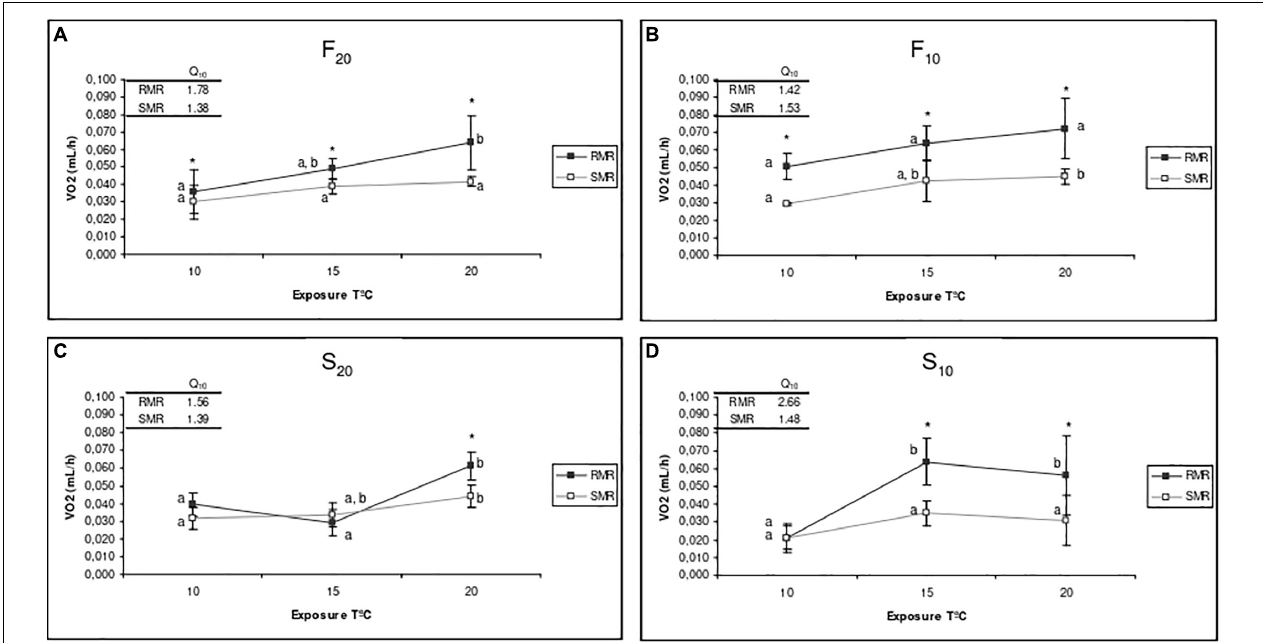
FIGURE 4 | Routine metabolic rate (RMR) and standard metabolic rate (SMR) of F 20 (A) , F 10 (B) , S 20 (C) , and S 10 (D) mussels at exposure temperatures of 10, 15, and 20 ◦ C. Mean value and standard deviation of five individuals from each group are shown for each experimental condition. The upper side of each graph shows the Q 10 values for RMR and SMR in the range 10–20. Asterisks indicate significant differences between RMR and SMR (ANOVA, p < 0.05). Letters indicate significant differences between exposure temperatures for each physiological parameter ( p < 0.05).